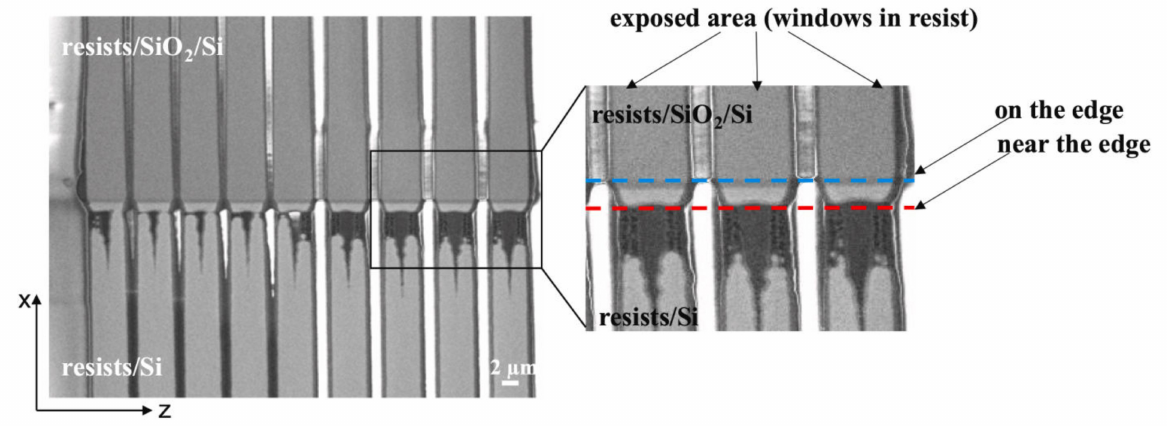
Figure 4. SEM image showing edge distortion of SiO 2 step. Reprinted with permission from [35]. Copyright 2022,